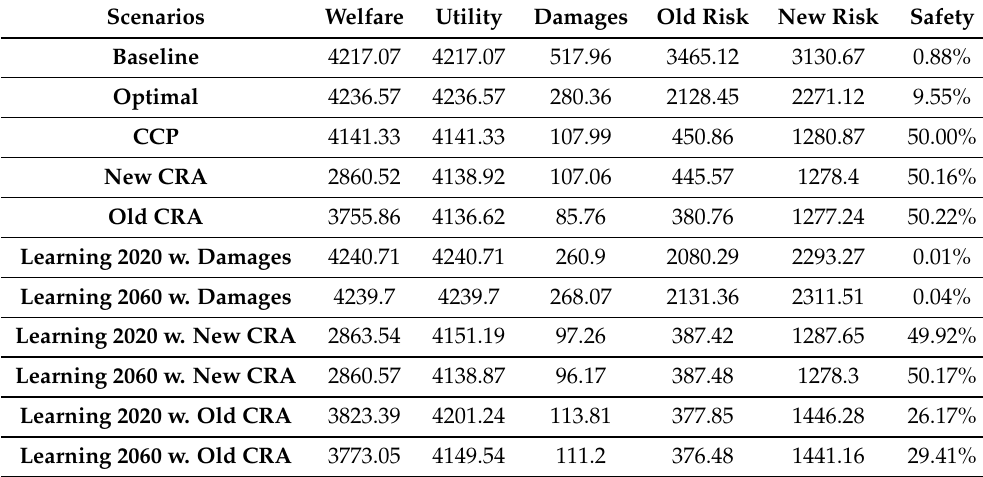
Figure A1. Atmospheric temperature evolution in New CRA and Old CRA for simulations with 100-time steps (500 years). The colors show different states of the worlds ranging from dark blue for the lowest climate sensitivity to dark red for the highest climate sensitivity. Table A1. Safety and expected value of welfare, utility, damages, old risk, and new risk for all